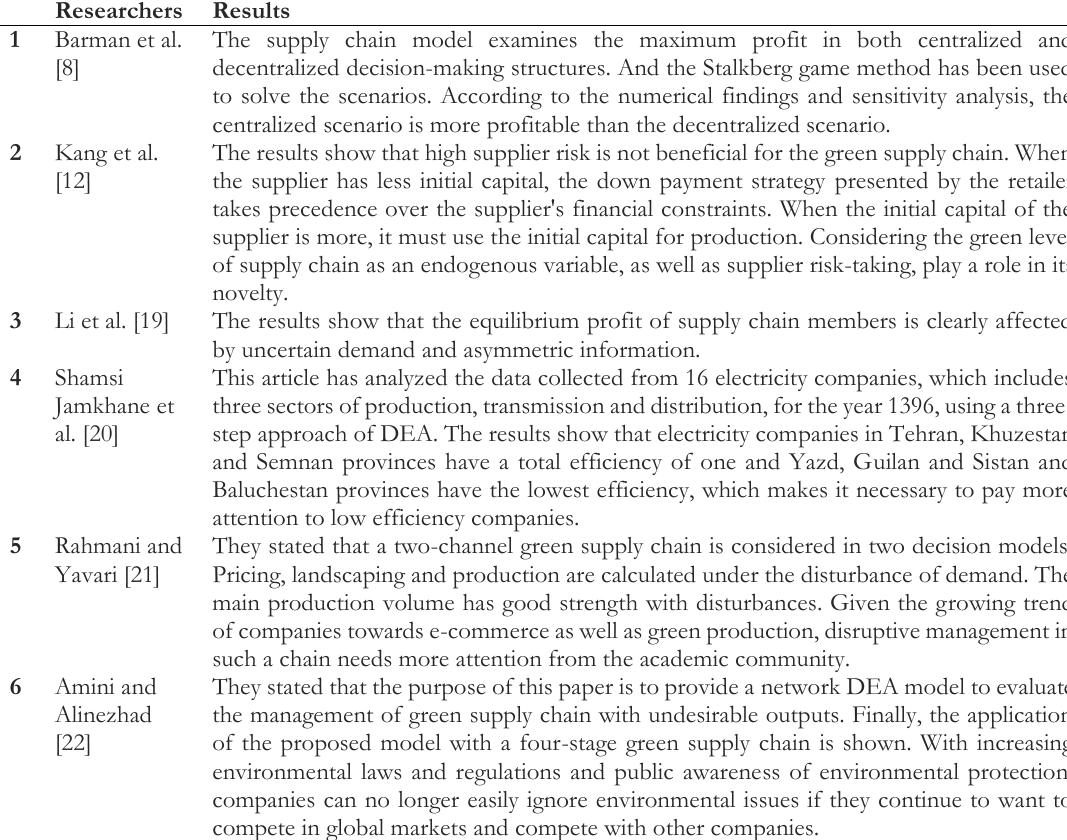
Table 1. Summary of literature